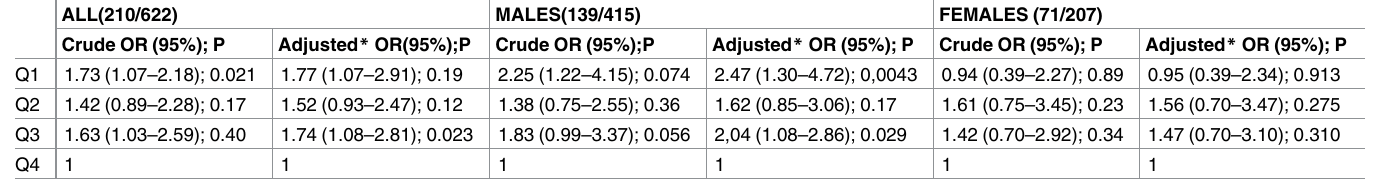
Table 2. Risk of CVD in relation to the highest quartile of IgM anti-OxPS. Associationbetweenlevels of IgM anti-OxPS and risk for CVD, (as compared to 622 controls) among all participants and men and women separately. In tables, the highestquartile, Q4, is set as 1. Both cases and controls were included as the basis for divisioninto quartiles.